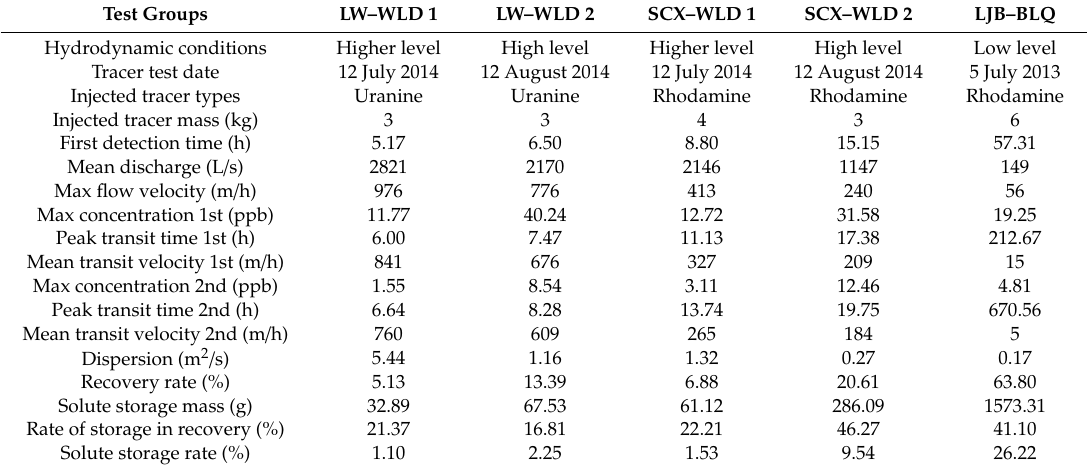
Table 1. Results of the artificial tracer tests and solute storage